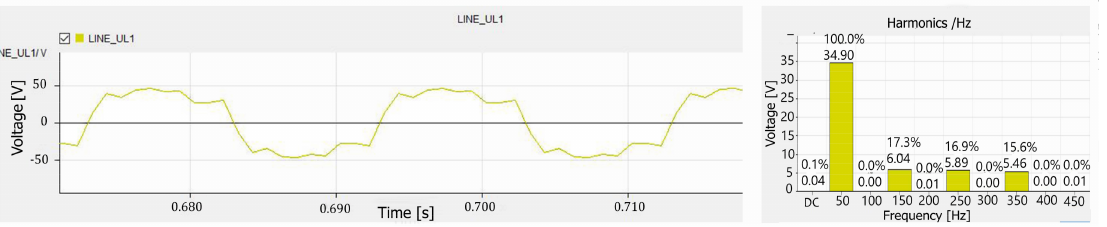
Figure 9. Decomposed voltage waveform with Fourier transform/Matlab